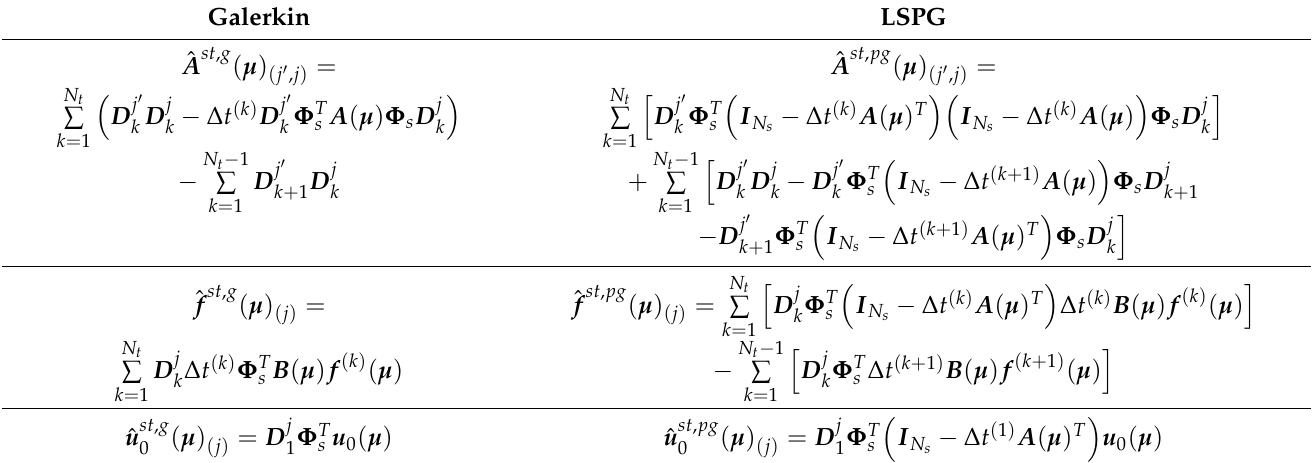
Table 2. Table 2. Comparison of Galerkin and LSPG block